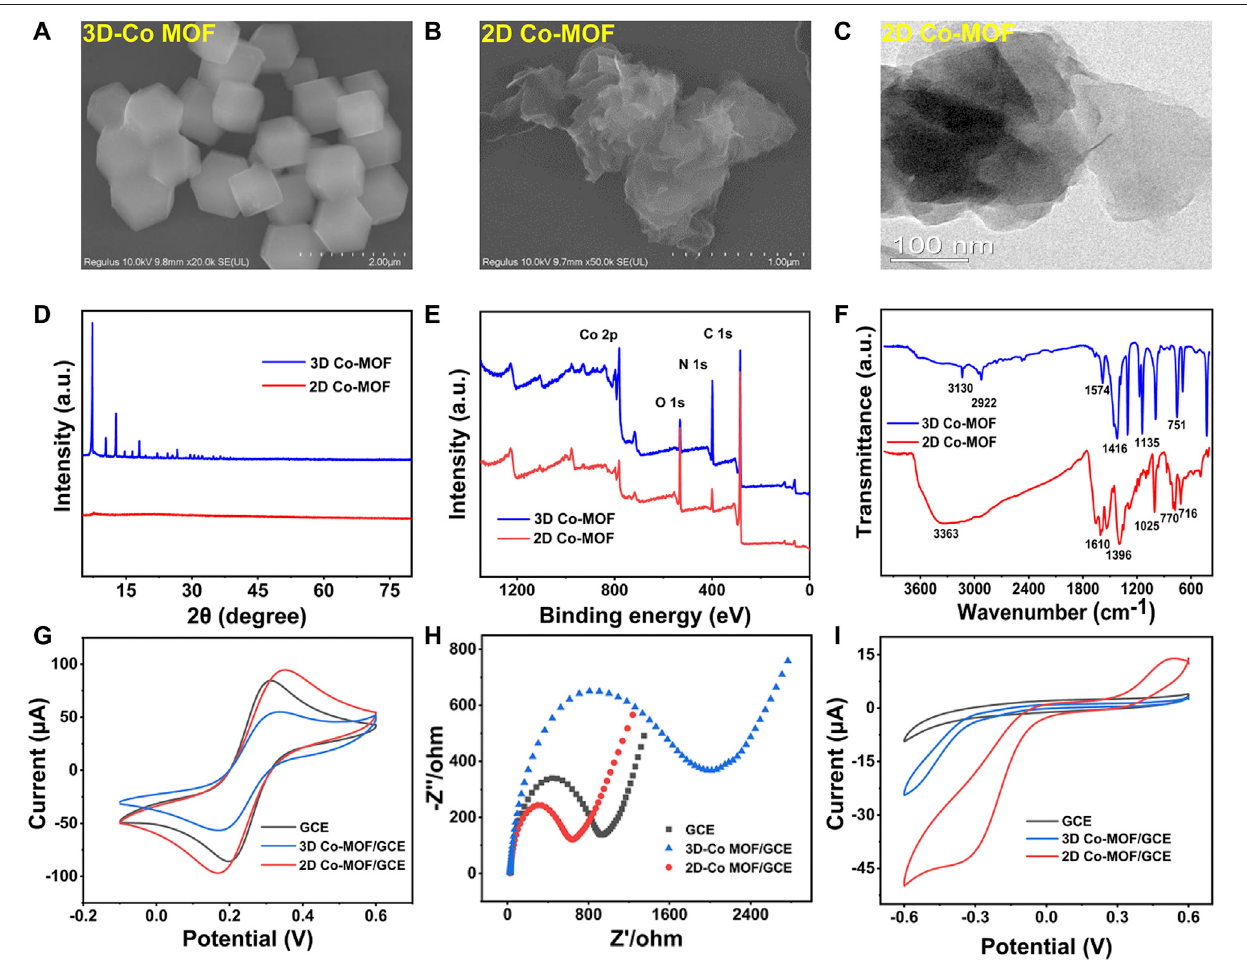
FIGURE 2 | SEM images of (A) 3D Co-MOF and (B) 2D Co-MOF. (C) TEM images of 2D Co-MOF. (D) XRD patterns of 3D Co-MOF and 2D Co-MOF. (E) XPS surveyscanof3DCo-MOFand 2DCo-MOF. (F) TheFTIRspectraof3DCo-MOF and2D Co-MOF. (G,H) CVcurvesand EIS curves ofGCE,3DCo-MOF/GCE,and 2D Co-MOF/GCE in5.0 mM K 3 Fe(CN) 6 /K 4 Fe(CN) 6 solutioncontaining0.1 MKCl(amplitude10 mV, impedance spectral frequency 0.1~10 5 Hz). (I) CVcurvesofGCE,3D Co-MOF/GCE and 2D Co-MOF/GCE in 100 mM PBS solution containing 10 mM H 2 O 2 at a scan rate of 100